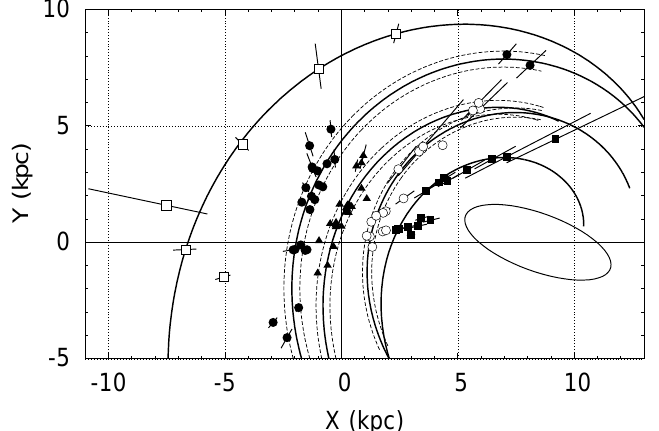
Fig. 4. Spiral pattern and the projected distribution of masers onto the Galactic plane: Outer arm (open squares), Perseus arm (solid circles), Local arm (solid triangles), Sagittarius arm (open circles), and Scutum arm (solid squares). The galactic bar is shown as an ellipse (J´ılkov´a et al., 2012). Table 1. Estimates of R 0 for five spiral segments. The number of triplets with the minimum heliocentric angle (∆ l ) min is designated as N ∴ . Me R 0 denotes the median of R 0 values found from all triplets. The R 0 , corr and σ R columns give the bias corrected 0 , J solar galactocentric distance estimate and its standard deviation, respectively, found using the jackknife technique, and ∆ R 0 , corr is the difference between R 0 , corr and Me R 0 .